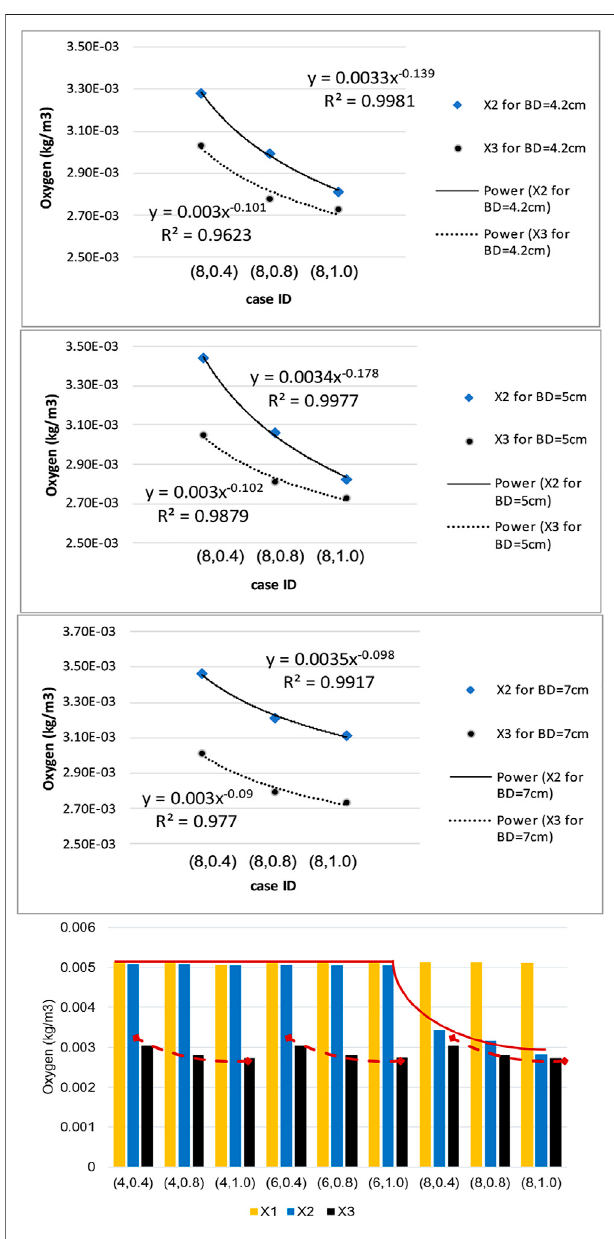
FIGURE 11 | Sensitivity results for dependence of wall oxygen concentration to the model parameters δ and l , and the schematic of the measuring indicator plots used in the